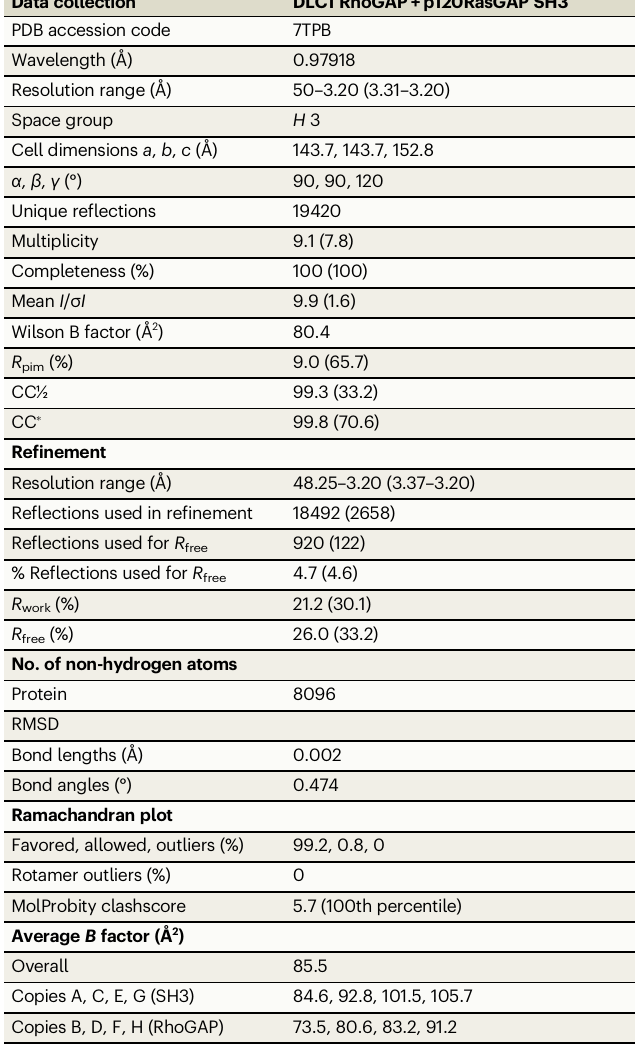
Table 1 | Data collection and re fi nement